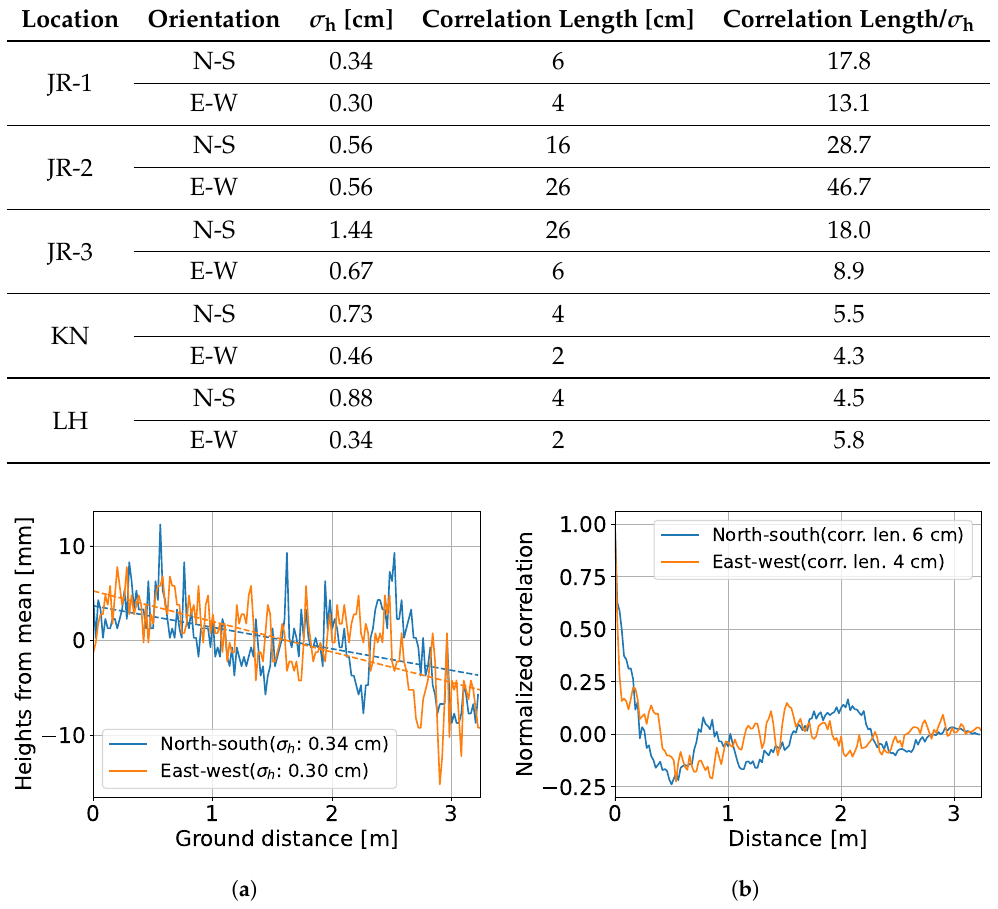
Table 1. Calculated surface roughness and surface correlation lengths for JER and WG sites based on laser range-finder measurements.